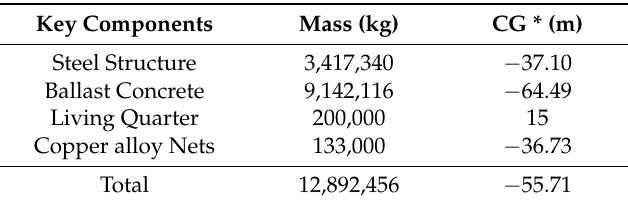
Table 2. Mass breakdown of fishing